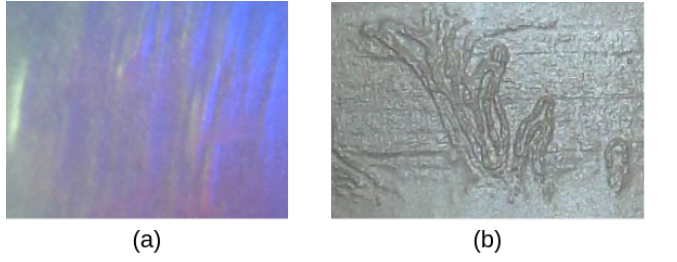
Figure 8. ( a ) The blurred tactile image collected by the GelSight while slipping on the fabric. ( b ) The clear tactile image by the TouchRoller while rolling over the same piece of